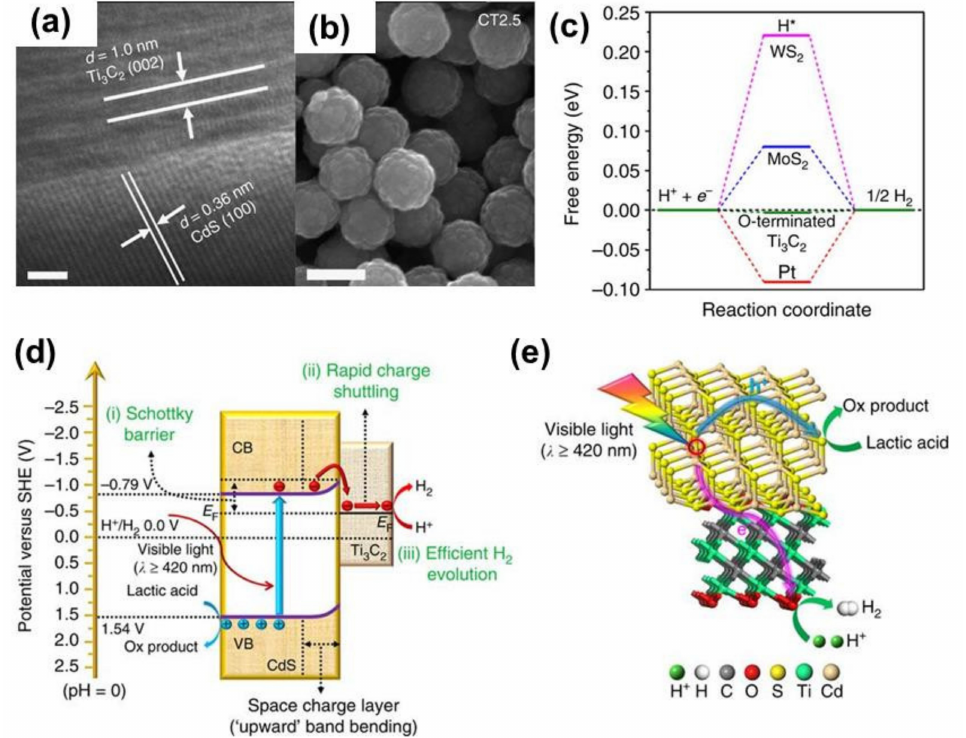
Figure 6. ( a , b ), TEM and SEM images of Ti 3 C 2 T x / CdS composite structure; ( c ) the calculated free-energy band diagram of HER with di ff erent catalysts including MoS 2 , WS 2 , and O-Ti 3 C 2 T x ; ( d ) band diagram of Ti 3 C 2 T x / CdS showing the charge separation and transferring from CdS to Ti 3 C 2 T x for HER; and ( e ) the proposed mechanism of HER over Ti 3 C 2 T x / CdS composite. Reproduced with permission from reference [61]. Copyright Nature Publishing Group,